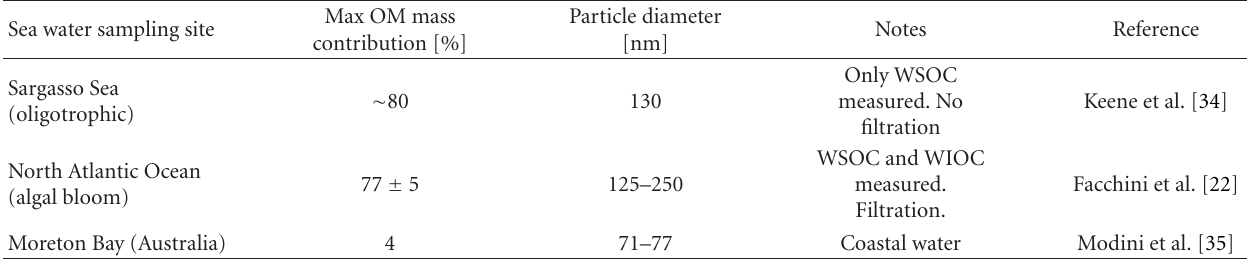
Table 2: Summary of the sea spray OM contribution measured in the most recent sea spray production laboratory